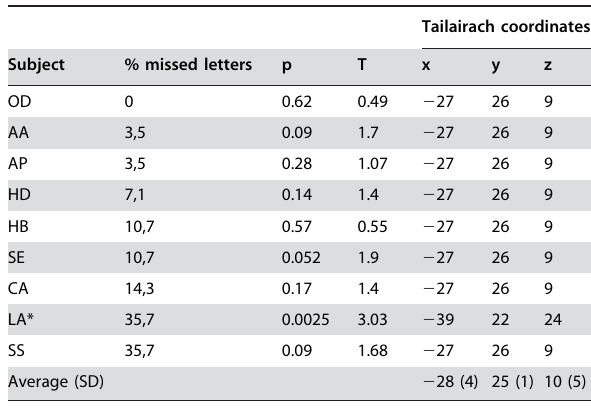
Table 3. Impairment in letter detection in individual subjects, t and p values for the individual contrast between dual task trials with long and short SOA, and talairach coordinates of the ventrolateral prefrontal region in which this contrast